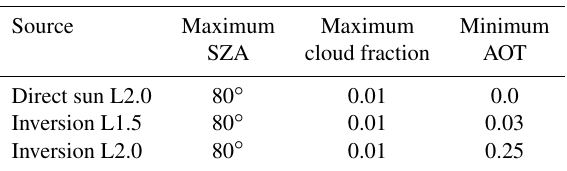
Table 3. Conditions for valid AERONET observations as simulated in this study.